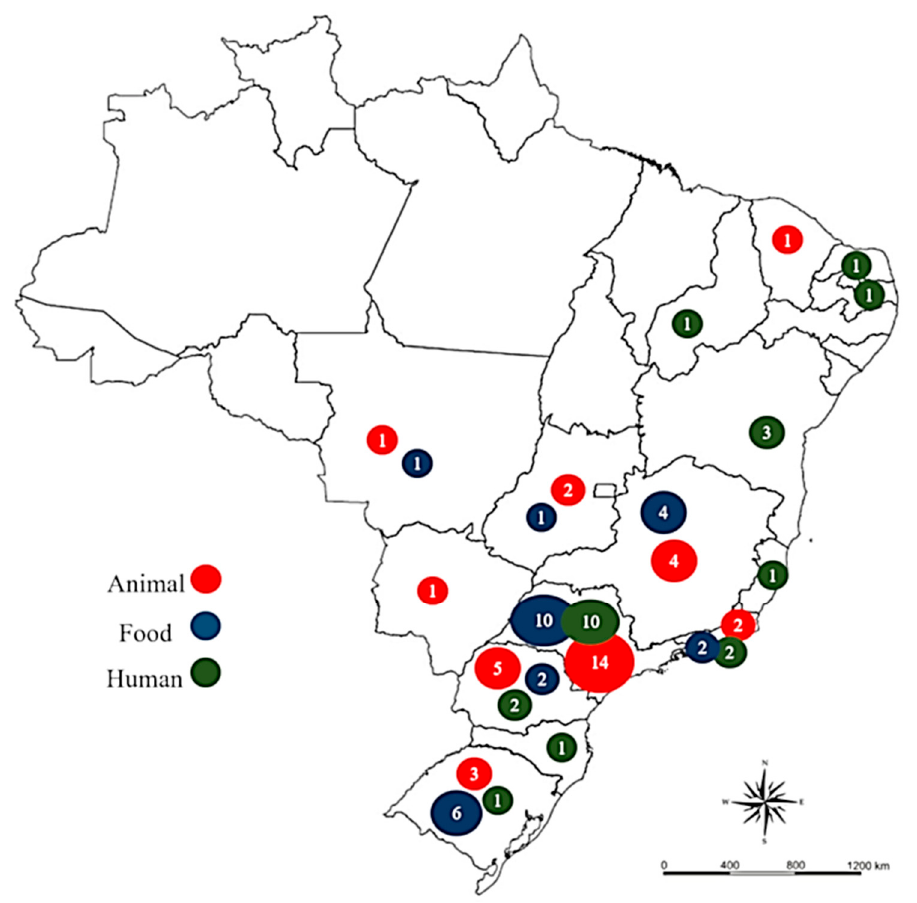
Figure 3. Distribution of STEC assessment studies carried out in Brazil from 2000 to 2018.